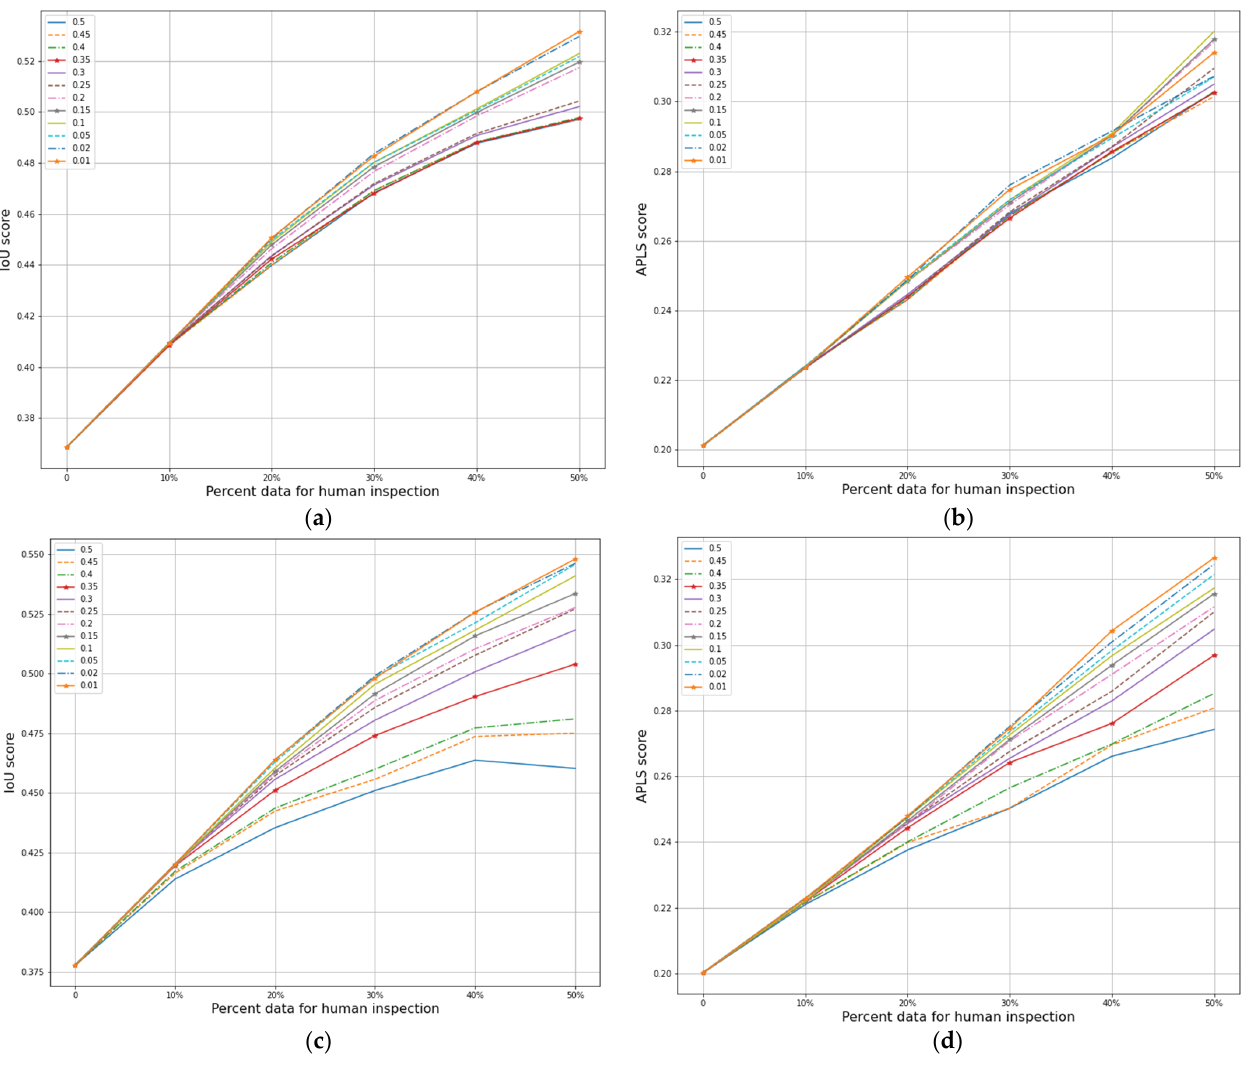
Figure 7. Performance comparison of MCD ( a , b ) and DE ( c , d ) model averages over varying decision thresholds for ID data. Scores increase substantially when using lower road class thresholds for uncertainty measurements, which are displayed for thresholds in the range [0.01,0.5] for the ID test set. This effect increases as more (higher confidence) image chips are sent to humans for quality assurance. The effect is more than twice as large for the DE than for MCD. The effect size for the deterministic model (not pictured) is similar to MCD.